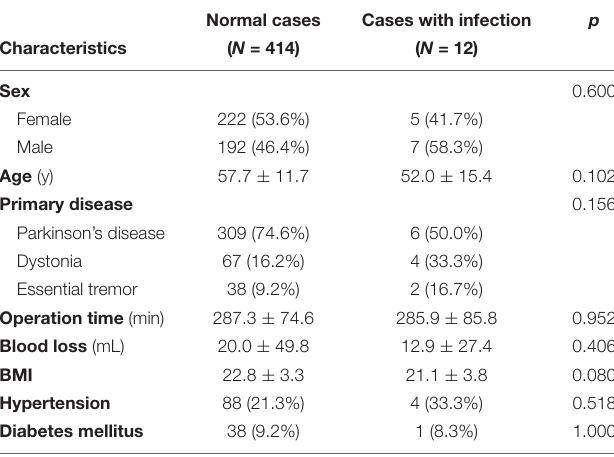
TABLE 2 | Characteristics of patients who developed infection after deep brain stimulation surgery.